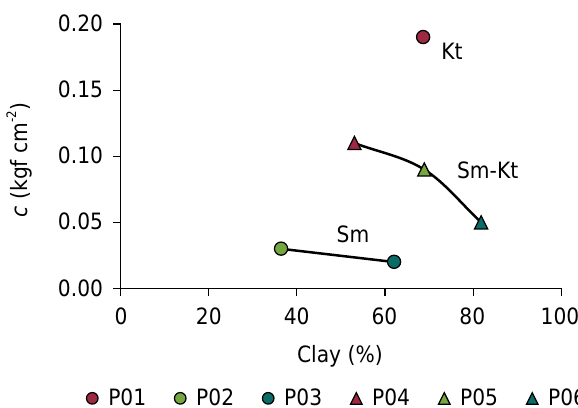
Figure 10. Variation in saturated soil cohesion (c) in comparison to clay content and types (Kt: prevalence of kaolinite; Sm: prevalence of smectite; Sm-Kt: codominance of smectite and kaolinite).